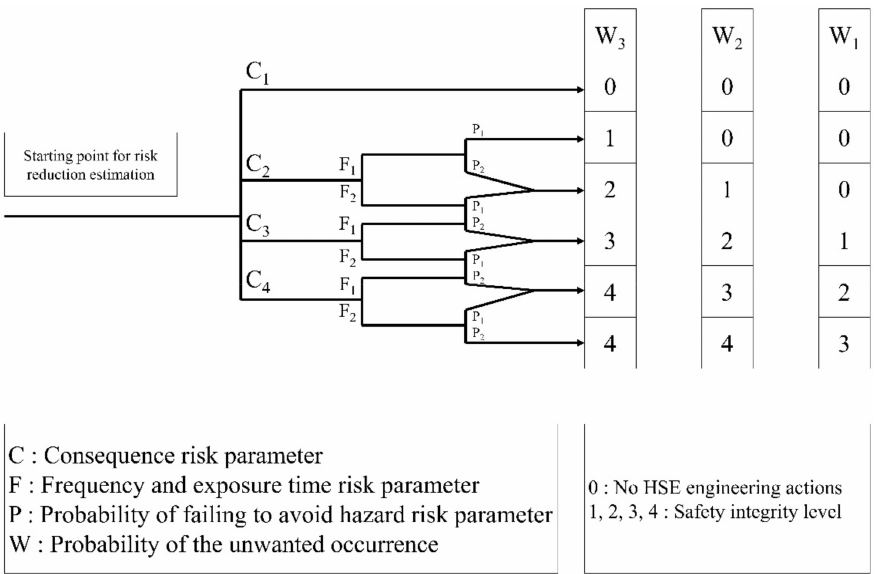
Figure 3. HSE-HAZOP: SIL Risk Graph for Personnel Safety.